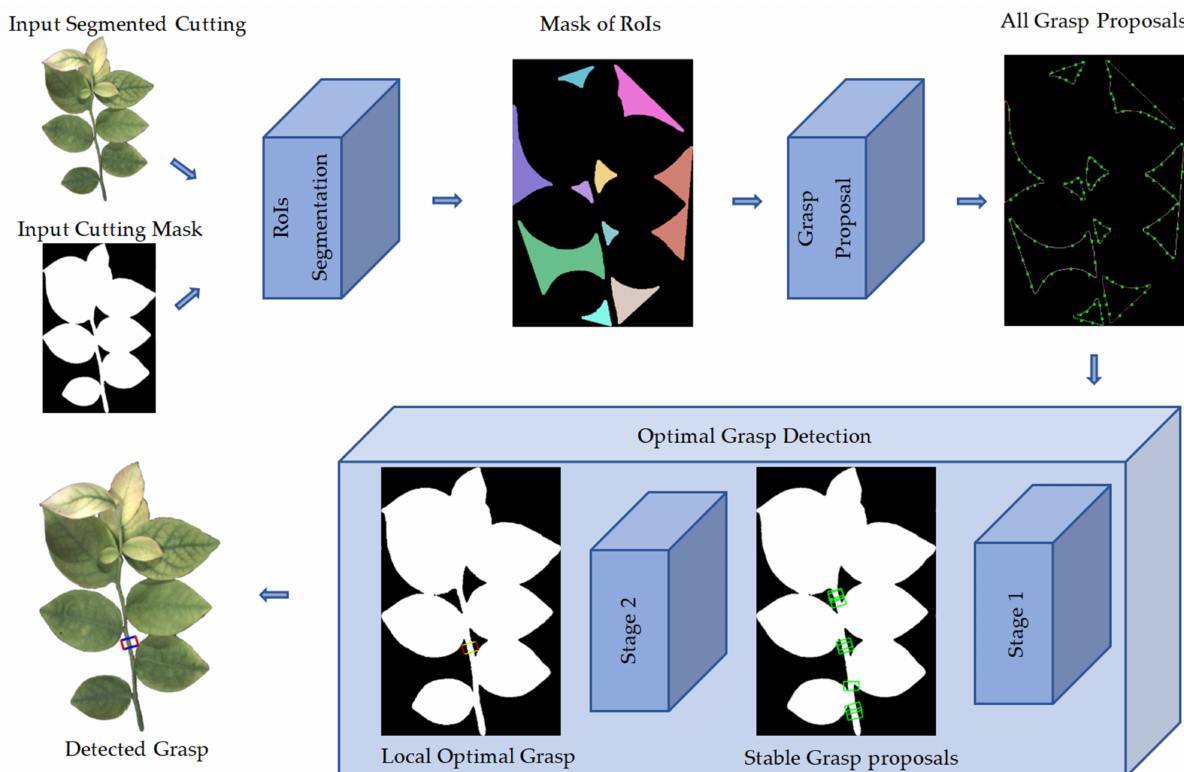
Figure 6. Pipeline of the proposed algorithm for detection of the robotic grasp of a segmented plant